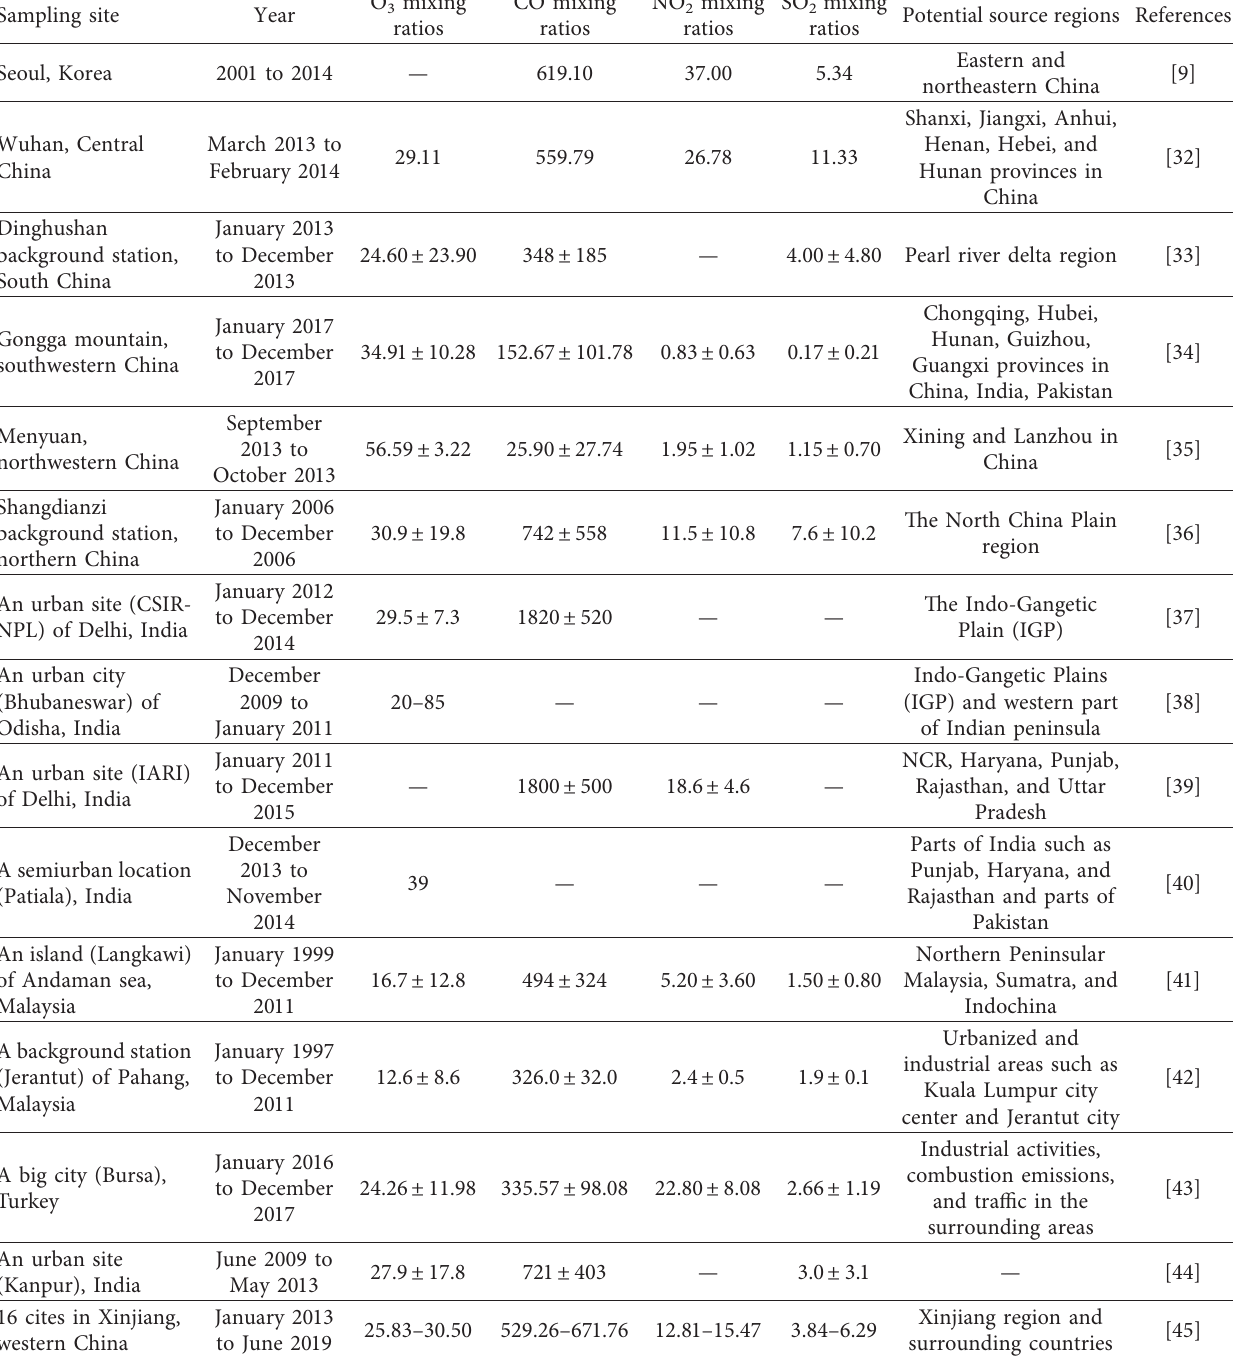
Table 1: Reactive gases (O 3 , CO, NO 2 , and SO 2 ) mixing ratios from other sites in Asia